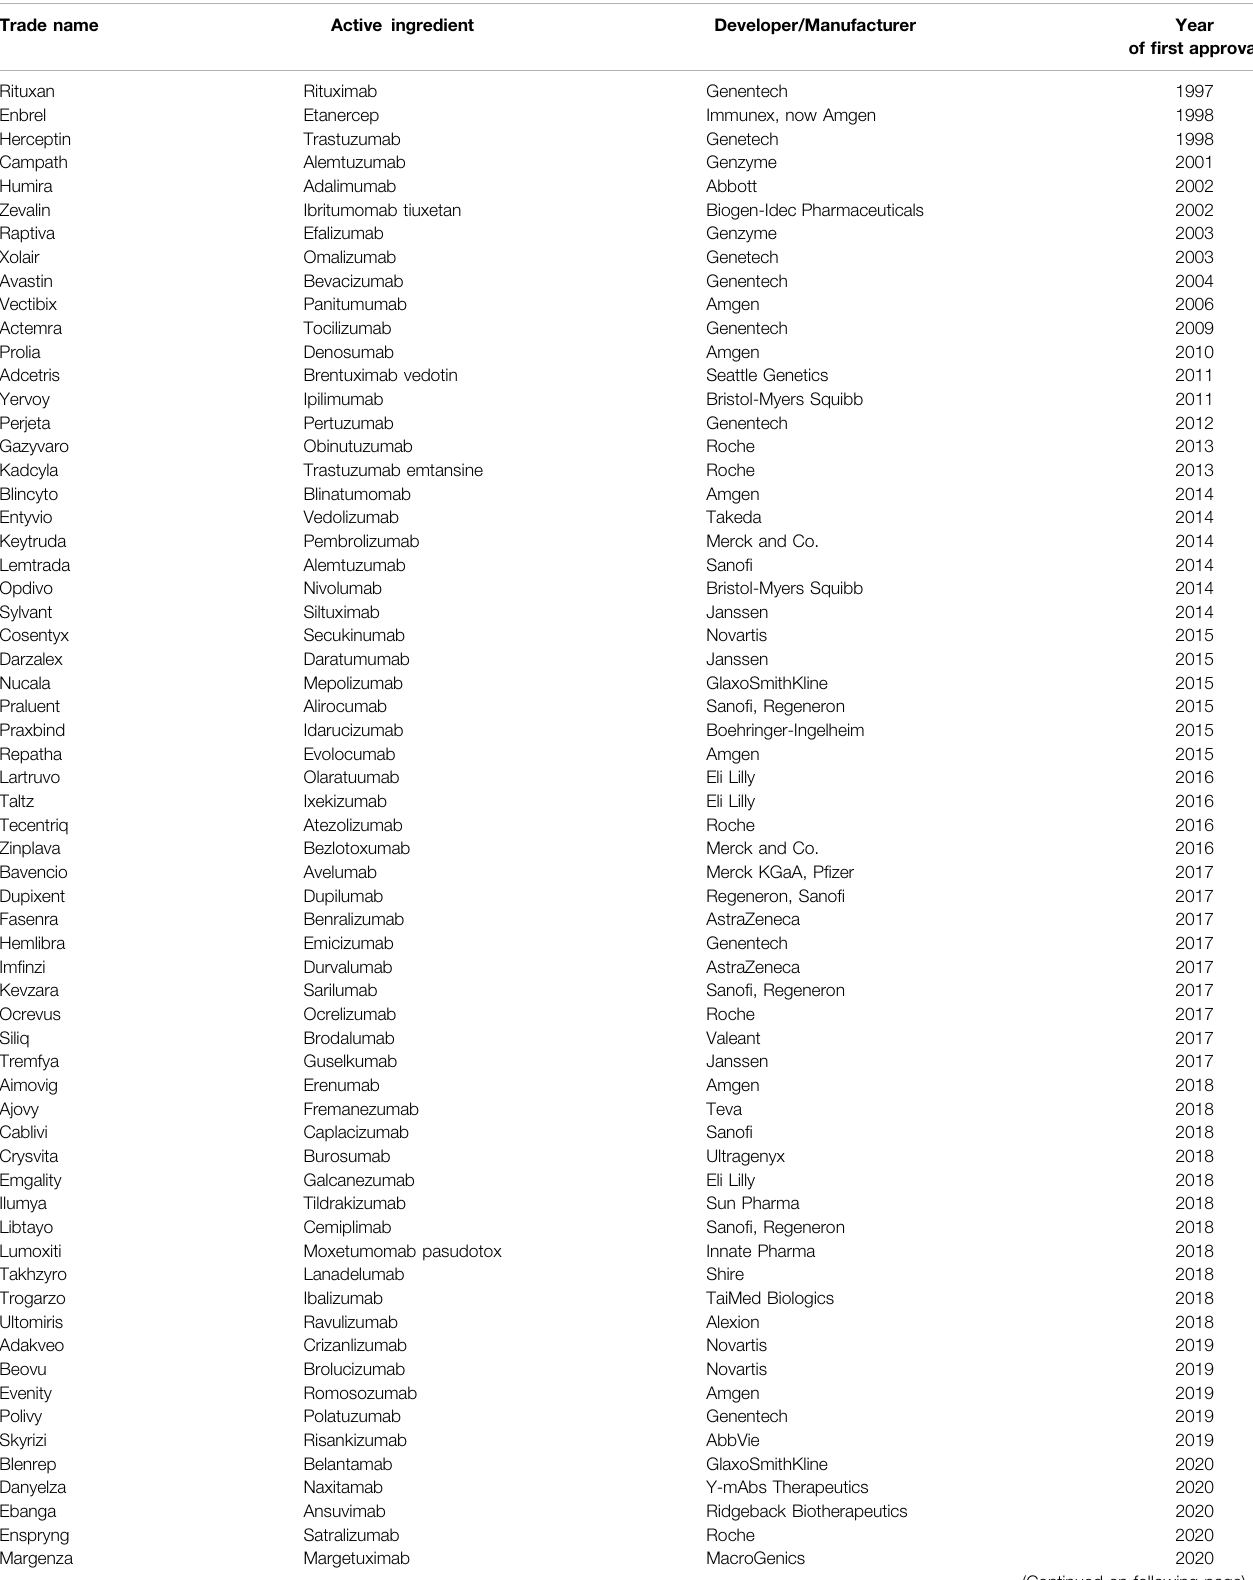
TABLE 1 | List of approved therapeutic monoclonal antibodies produced in CHO cells. Trade